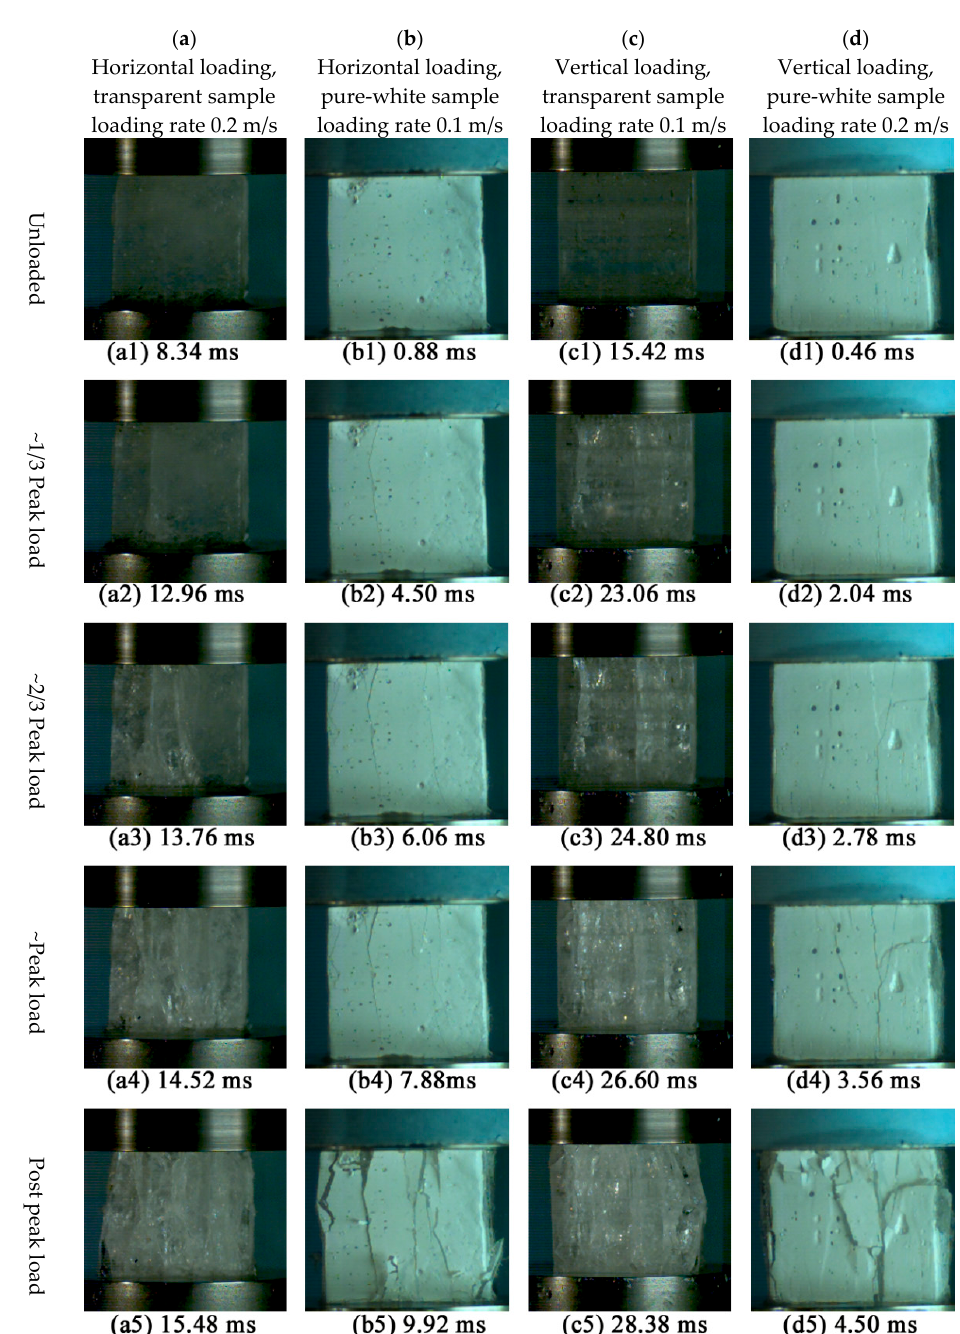
Figure 15. Failure processes of soft ice at moderate rates: ( a , b ) the horizontal loading failure process of soft ice; and ( c , d ) the vertical loading failure process of soft ice. The recording rate of high-speed camera is 50,000 fps.